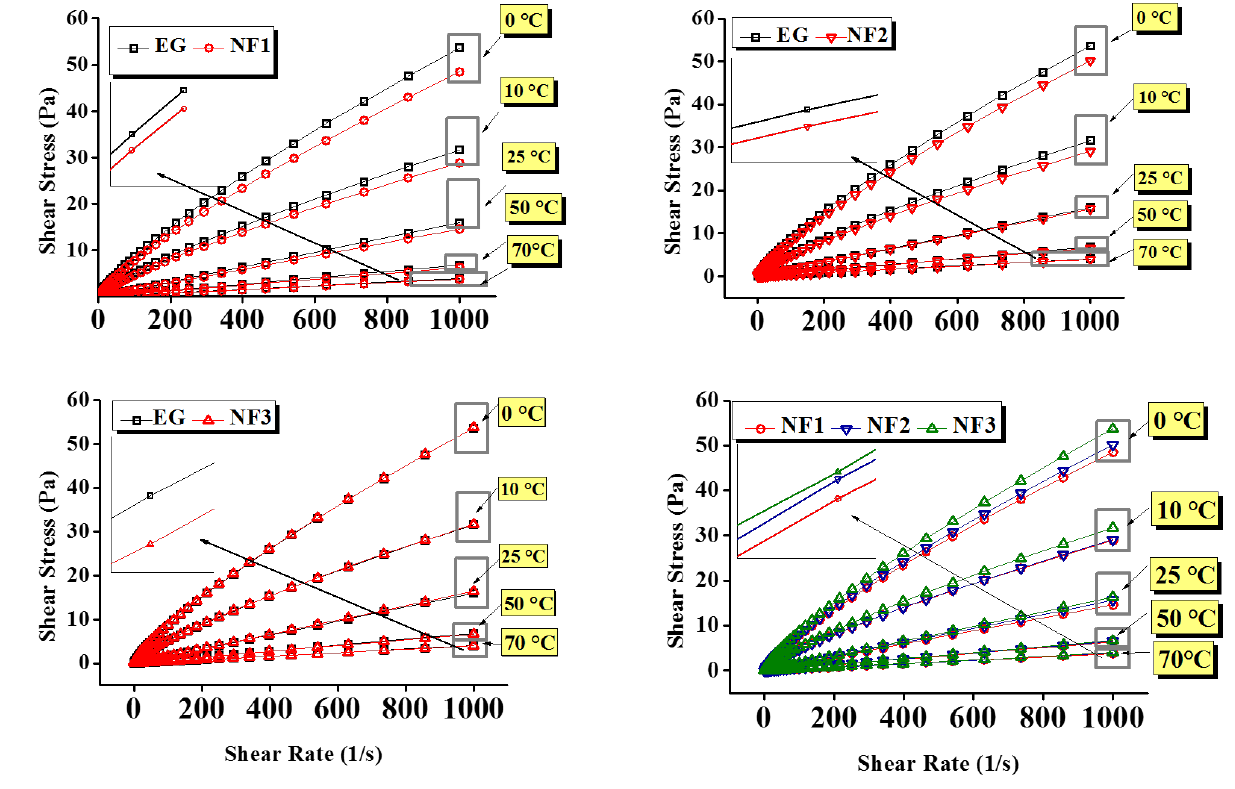
Figure 6. Flow curves of nanofluids and EG as a function of shear rate over various concentrations (NF1—0.005%; NF2—0.0075%, and NF3—0.01%) and steady-state temperatures (0–70 ◦